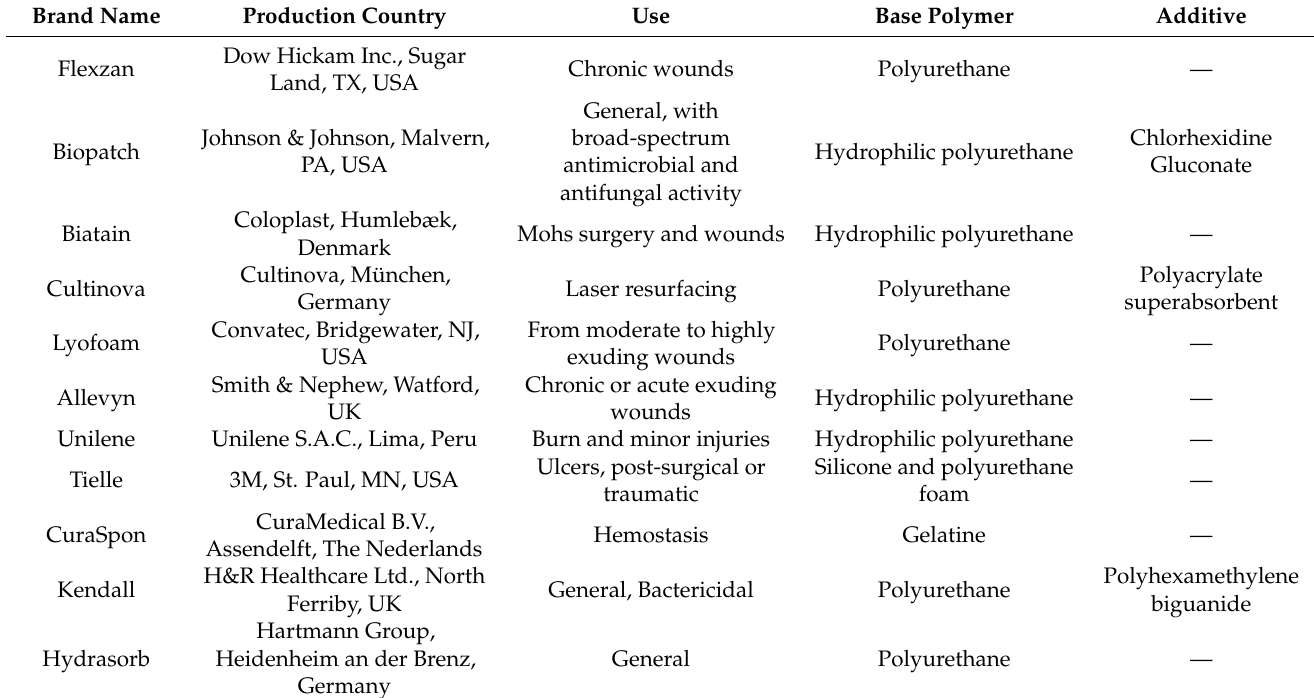
Table 2. Common foam based wound